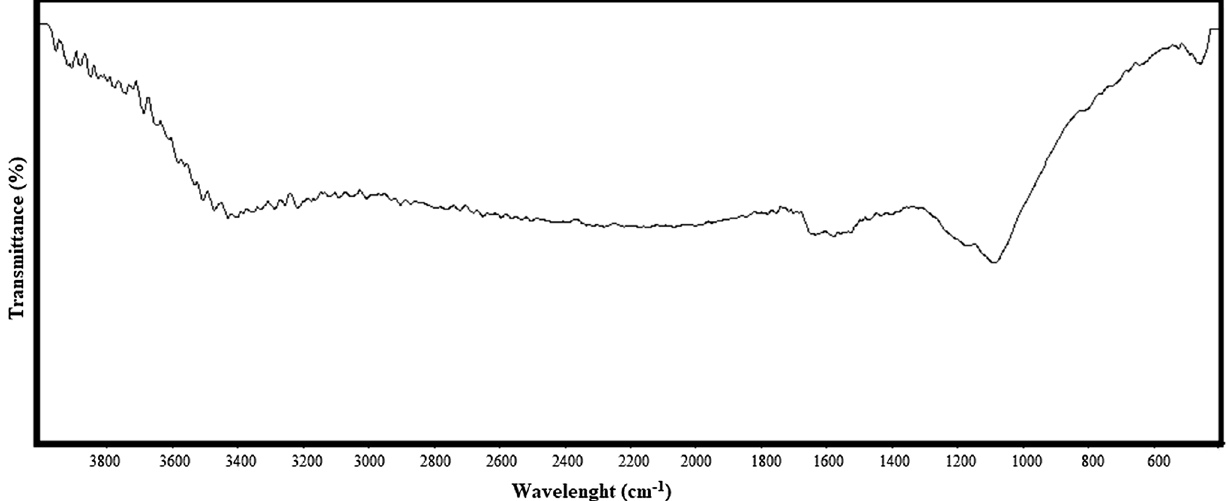
Fig. 6 FTIR spectrum of KOH activated carbon